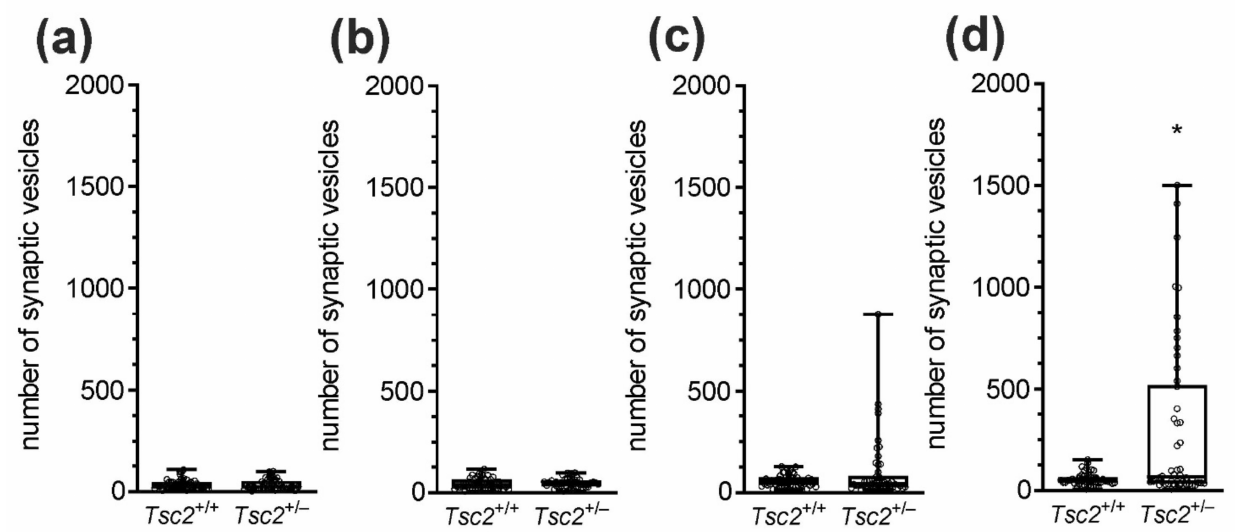
Figure 6. The effect of Tsc2 haploinsufficiency on the number of synaptic vesicles in ( a ) cerebral cortex, ( b ) cerebellum, ( c ) CA1/CA2 region of the hippocampus, and ( d ) CA2/CA3 region of the hippocampus. The quantitative analysis of microphotographs was performed for 5 animals in each group; 10 random synapses from each animal were taken for analysis ( n = 50). Data were not normally distributed and are presented as medians with interquartile ranges, minimums, and maximums. * p < 0.05 vs. wild-type animals, as determined using the Mann–Whitney